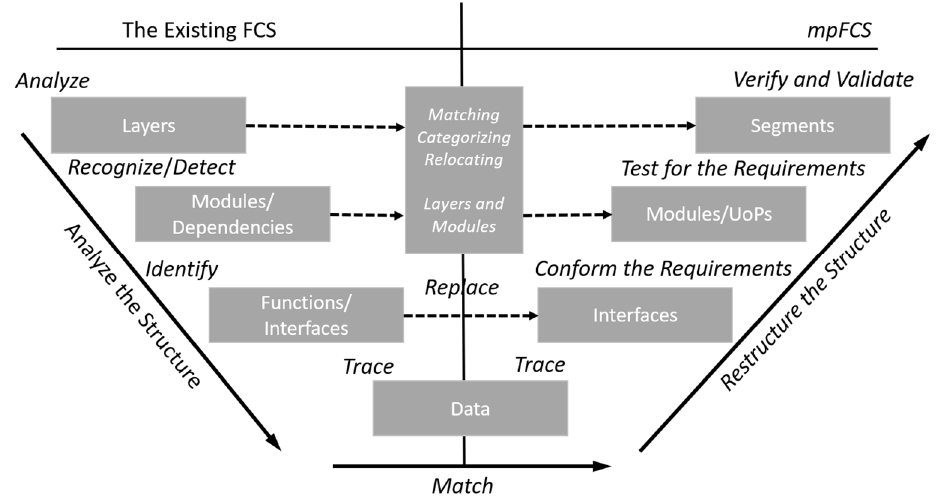
Figure 4. The AMR-Process of matching the existing FCS into the FACE architecture.